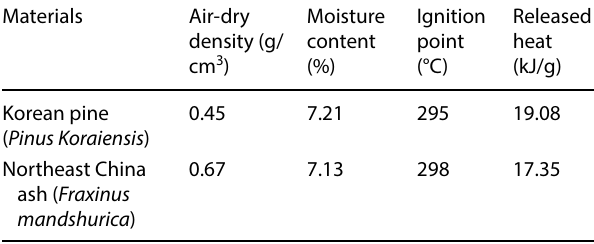
Table 2 Fundamental physical characteristics of workpiece materi- als Materials Air-dry density